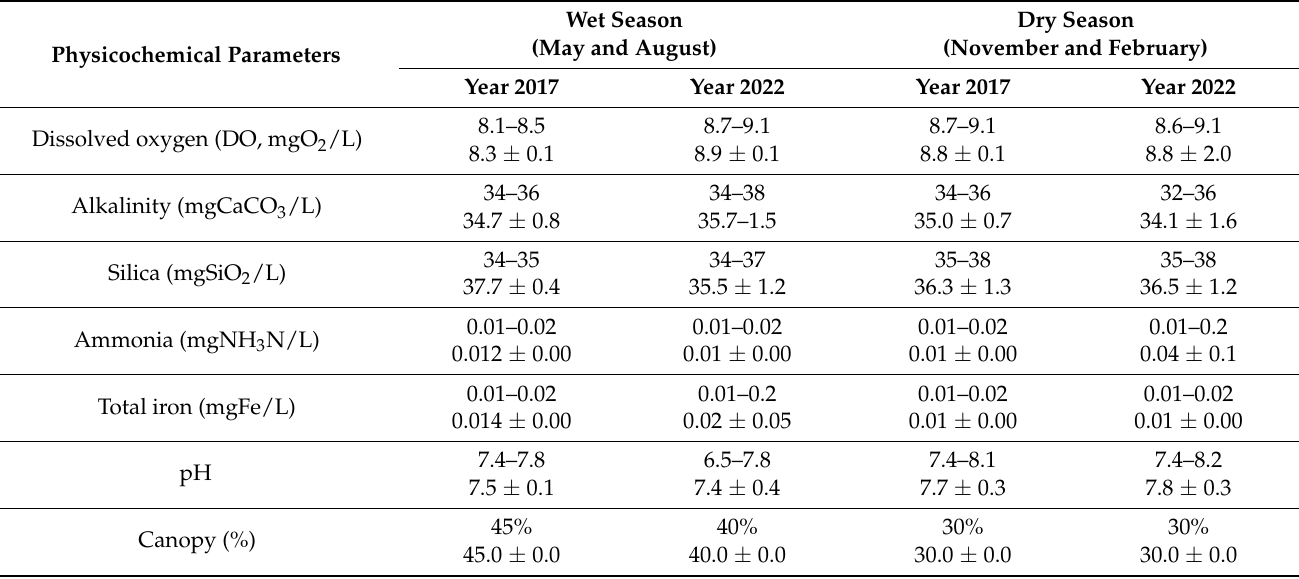
Table 1. Physiochemical parameters of Pakkok River, Kwai Noi River system, Mae Khlong basin, Kanchanaburi province, Thailand during the wet and dry seasons of 2017 and